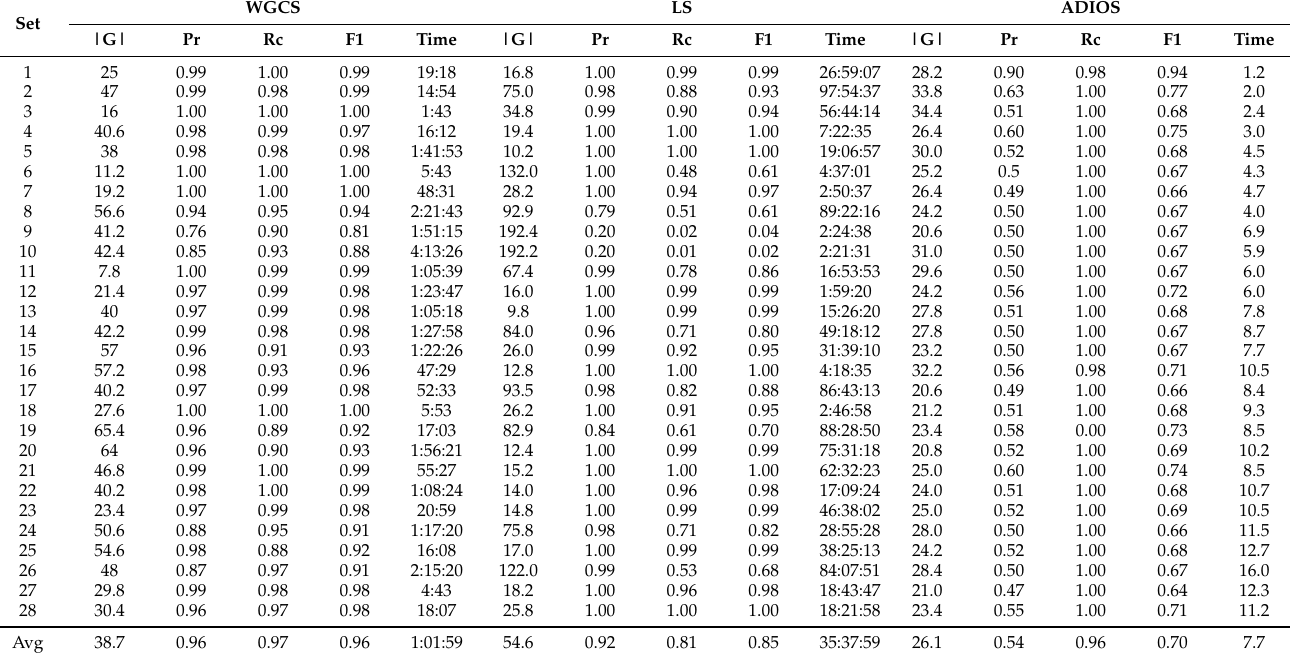
Table 2. Average grammar size (|G|), Precision (Pr), Recall (Rc), F1, and average time ([[hh:]mm:]ss) for WGCS, LS and ADIOS.